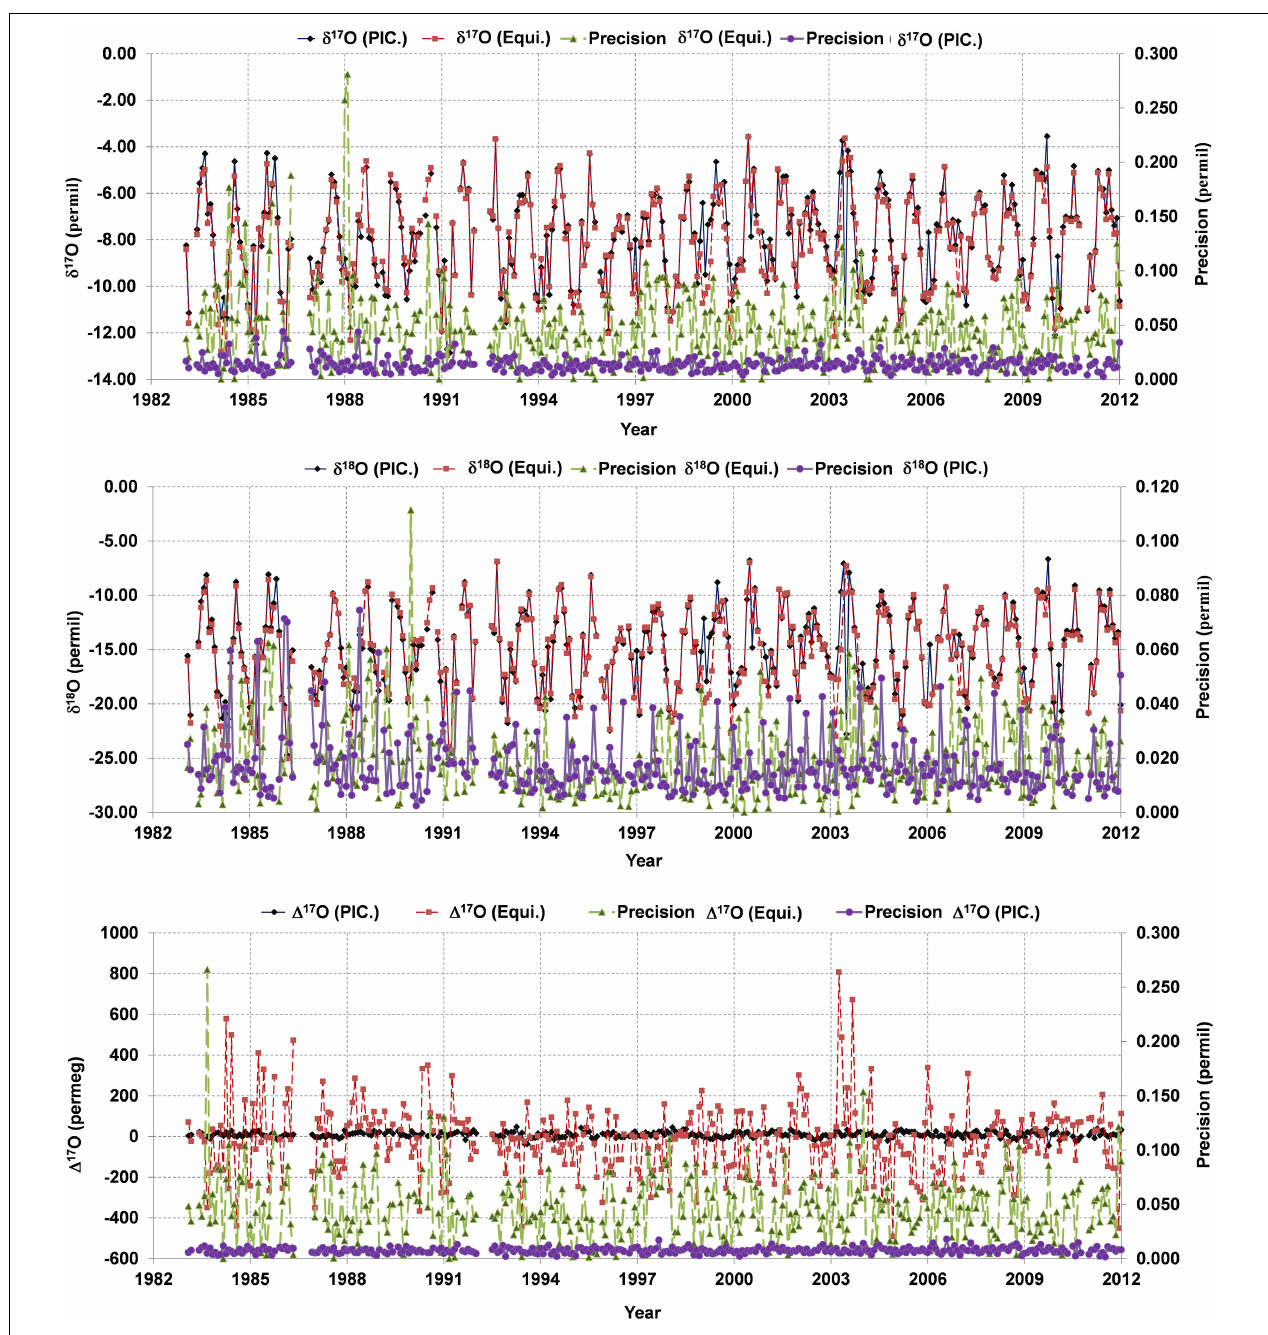
FIGURE 5 | A comparison of the CO 2 -H 2 O equilibration (EQUI) method and laser-based system (LBS), obtained from Picarro L2140 i (PIC.) for triple oxygen isotopes. (cid:49) 17 O and δ 17 O precision for the EQUI method is significantly lower compared to the LBS. The precision of δ 18 O in the EQUI method is close to the LBS.